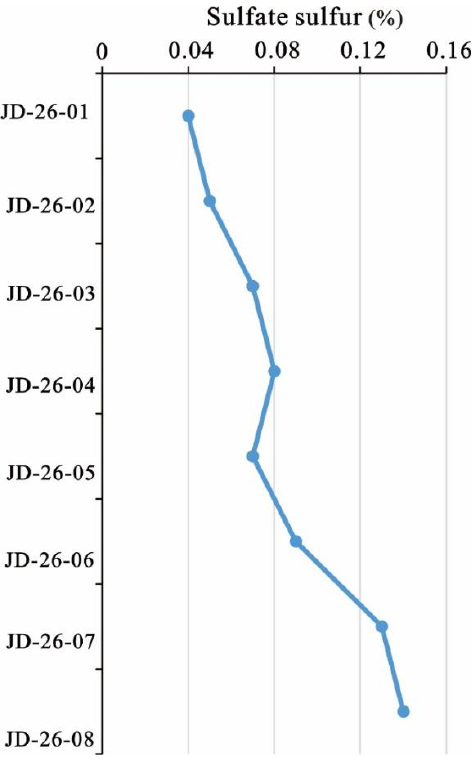
Figure 16. Regularity of the variation of sulfate sulfur in the Junde samples.